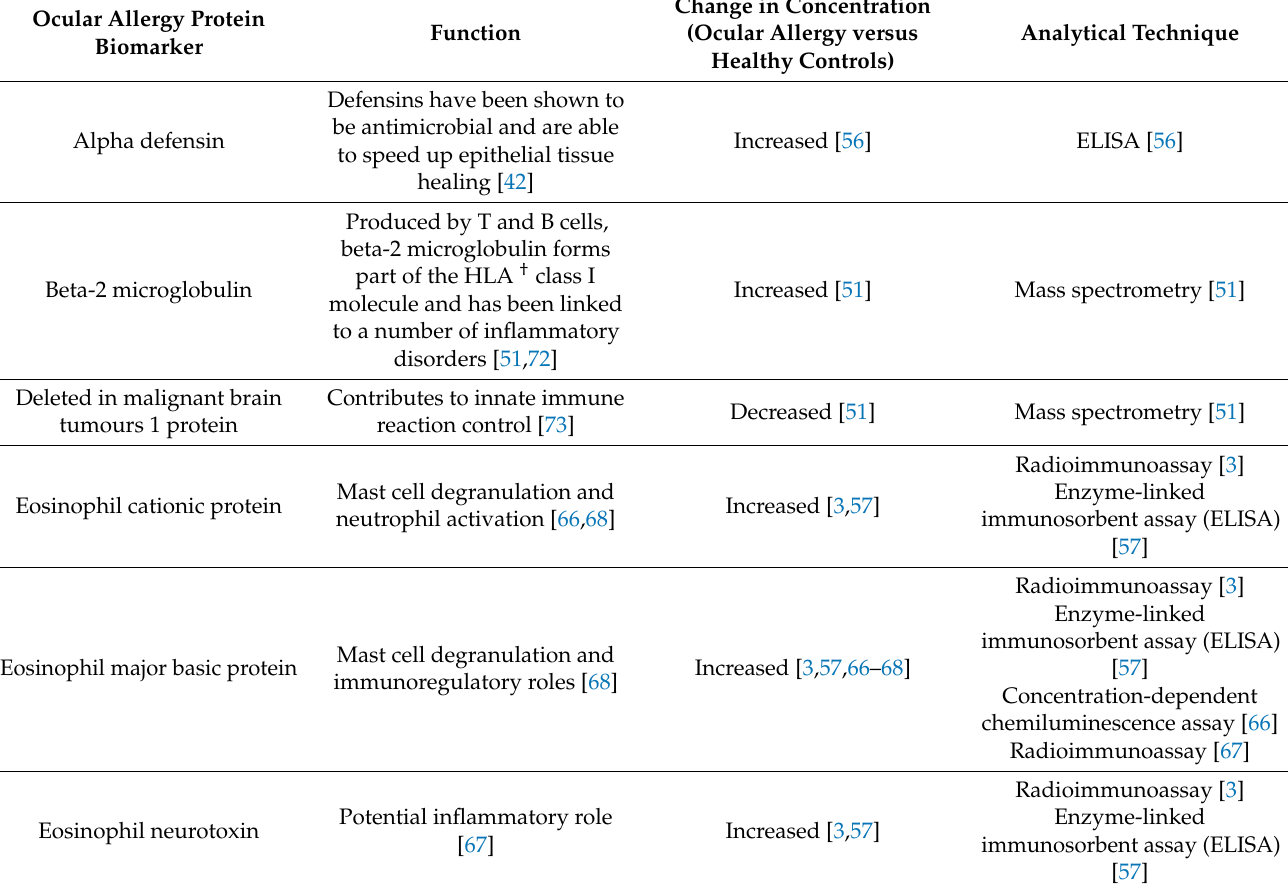
Table 1. Potential ocular allergy biomarkers identified by previous studies and their associated functions. Ocular Allergy